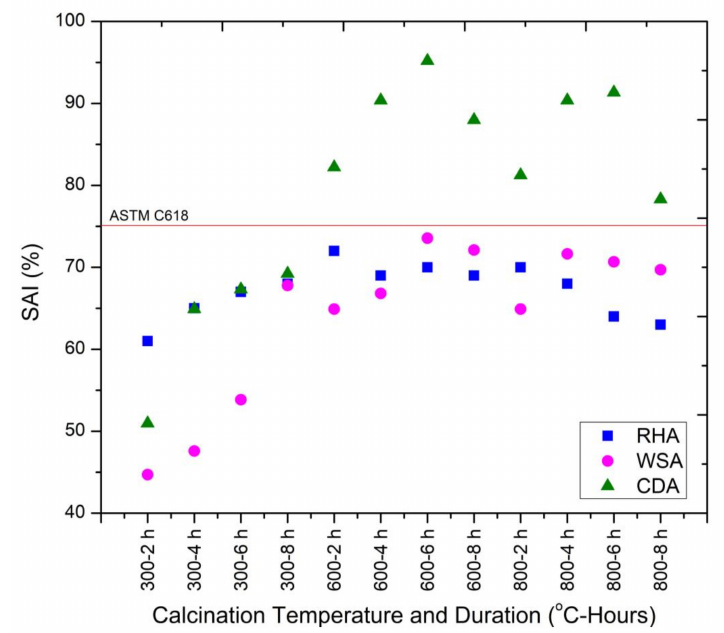
Figure 7. SAI of RHA, WSA, and CDA samples at different incineration temperatures.